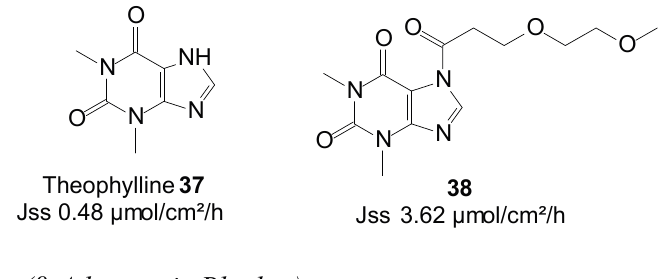
Figure 10. Theophylline and its best skin penetrant amide prodrug.